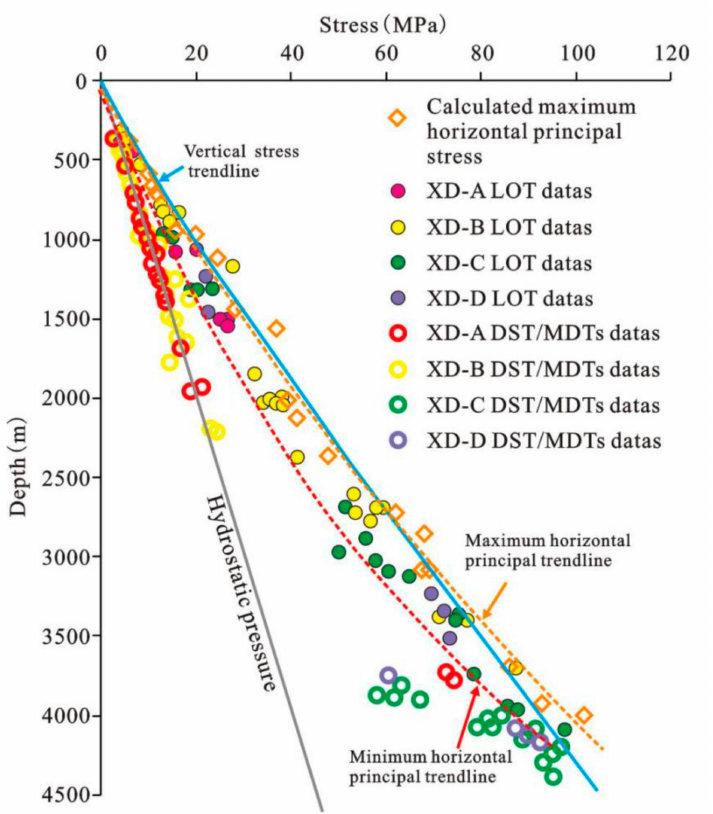
Figure 7. Horizontal principal stress in study area. S Hmax is calculated by the Hubbert–Willis equation [50] under the assumption of zero tensile strength. S Hmax is interpreted from LOTs and XLOTs. The data show the characteristics of stress pressure coupling, that is, the horizontal principal stress increases with the pore fluid pressure increasing